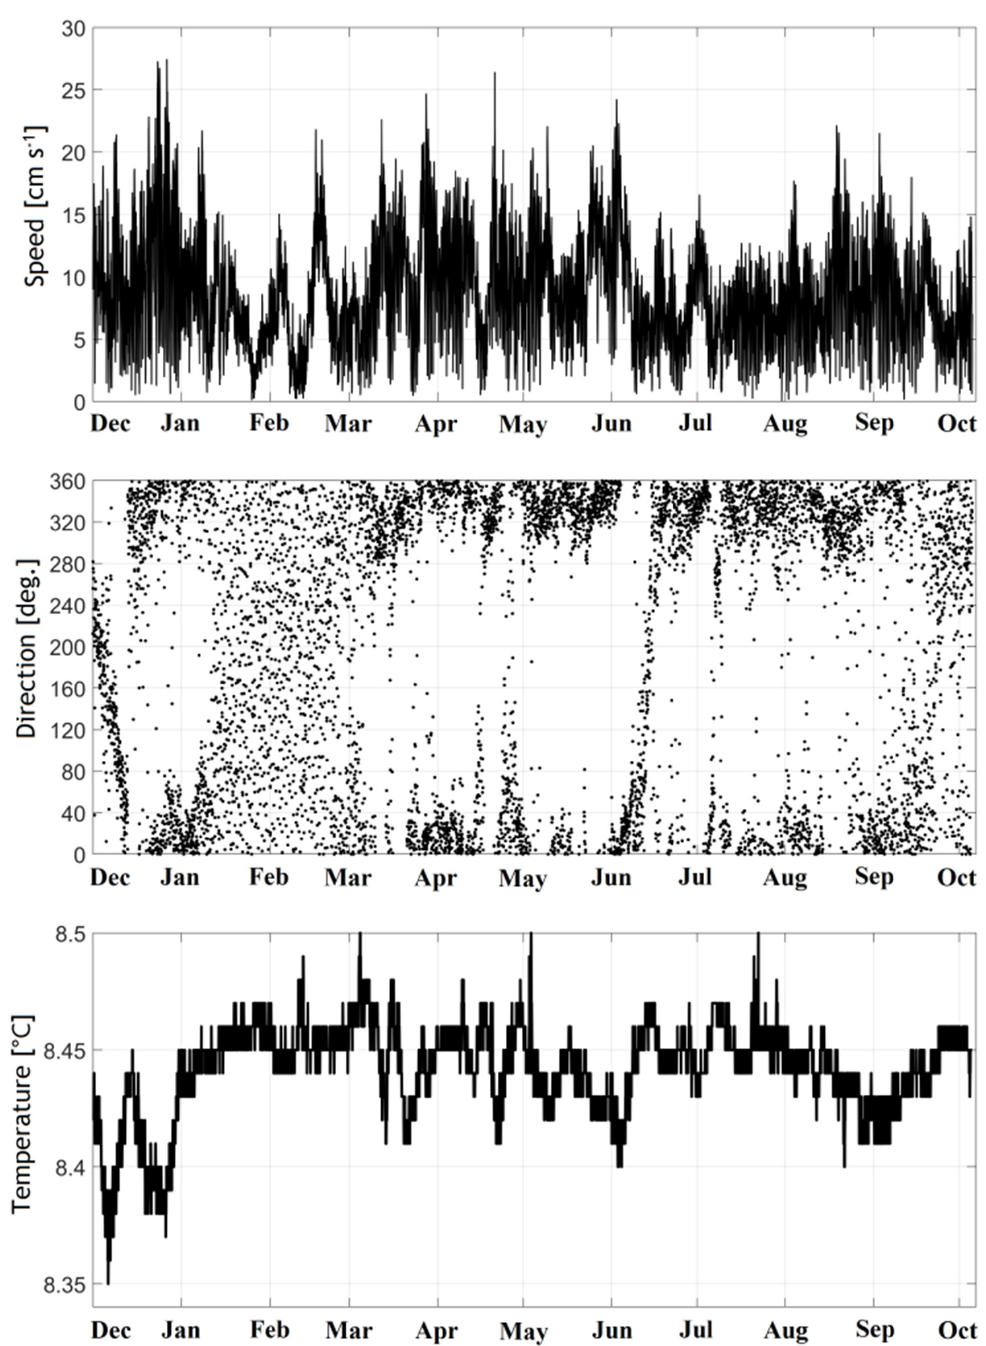
Figure 3. Time series of current speed ( top ) and direction ( middle ) and temperature ( bottom ) at the 100 m depth at ABS No. 1 from 1 December 2016 to 5 October 2017. The graphs are based on data averaged over 1 h.